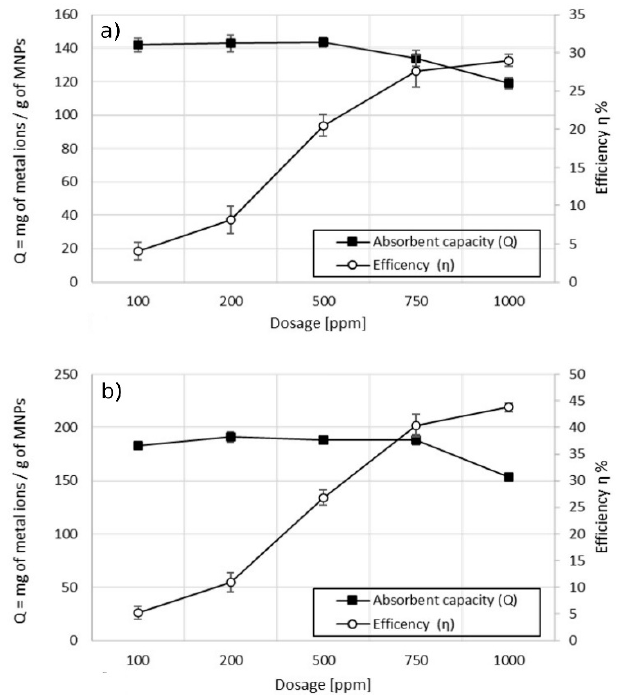
Figure 7. Effect of the dosage on adsorption capacity vs. efficiency. ( a ) MA with 5% w/w of coating; ( b ) MA with 10% w/w of the coating, pH 6.9. ( b ) MA with 10% w / w of the coating, pH